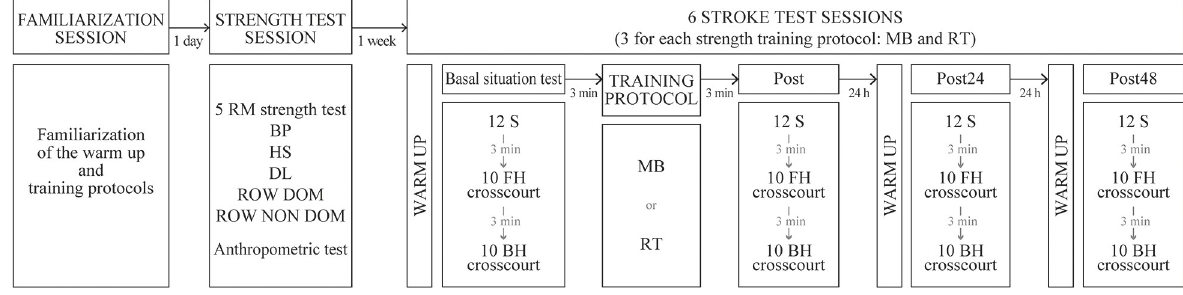
Fig 1. Study design chronology. MB = medicinal ball throws; RT = resistance training; BP = bench press; HS = half squat; DL = dead lift; ROW DOM = dominant hand row; ROW NON DOM = non-dominant hand row; S = serve; FH = forehand; BH = backhand.